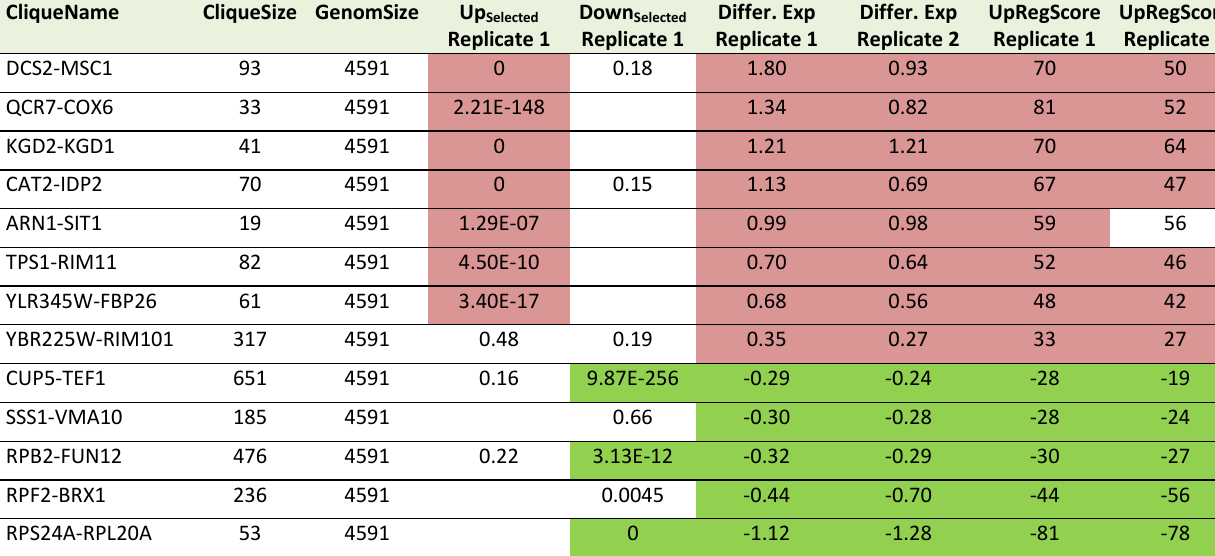
TABLE 4. Most prominent hits from differential expression in glucose versus glycerol based growth within the 72 expression cliques for replicate 1 and replicate